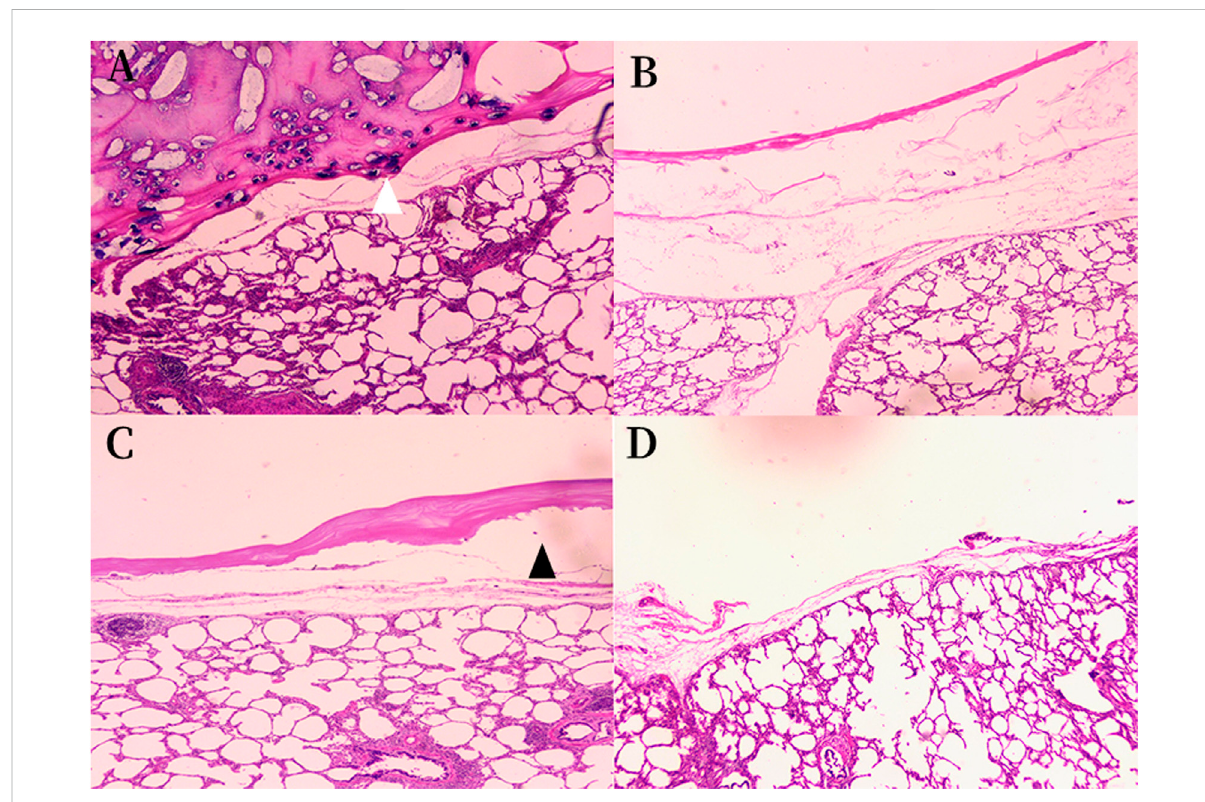
FIGURE 7 Histologic fi ndings of the sealing materials on the intersegmental plane of the lung (original magni fi cation ×40). (A) Group A ORC + fi brin glue, hematoxylin-eosin staining; (B) Group B PGA + fi brin glue, hematoxylin-eosin staining; (C) Group C fi brin glue, hematoxylin-eosin staining; (D) Group D control group, hematoxylin-eosin staining. (A) The sealing layer of ORC and fi brin glue adhered tightly to the intersegmental plane, some black gel blocked the pleural defect (white arrowhead). (B) The sealing layer of PGA and fi brin glue adhered fi rmly to the intersegmental plane. (C) A gap was observed between the sealing layer and the intersegmental plane (black arrowhead) in the group C. The sealing layer did not fi t evenly with the surface of the lung tissue, and the thickness of it was not as uniform as that in groups A and B. (D) The normal intersegmental interface separated by electrocauterization. The pleural defect was severe due to the cauterization of the electric cautery. ORC (oxidized regenerated cellulose), PGA (polyglycolic